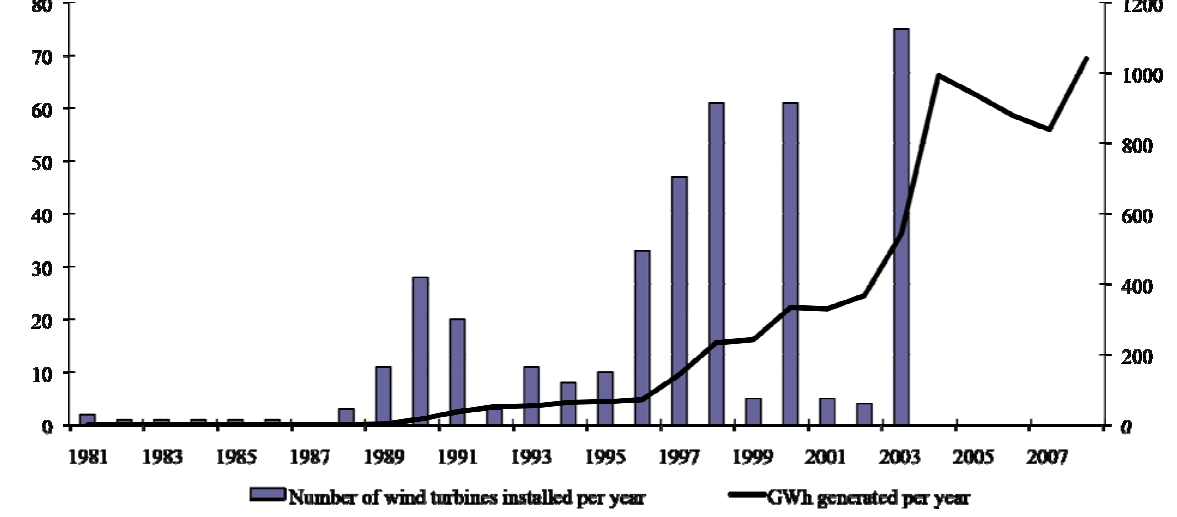
Figure 2. Wind turbine developments on